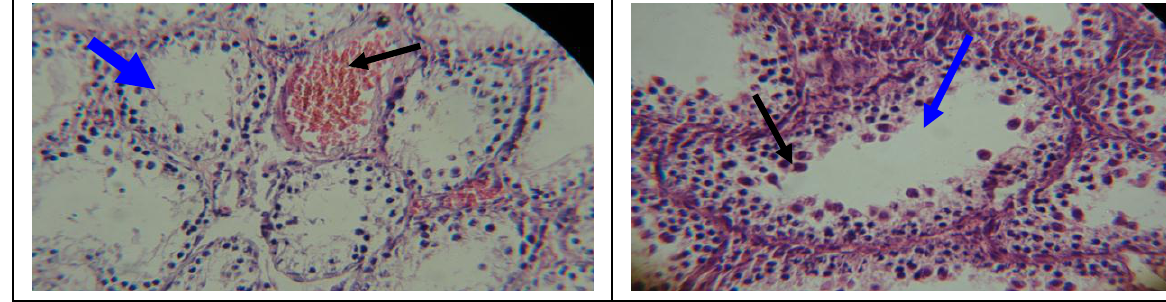
Figure(2): Histopathological section of testis of mice in therapeutic group treated with (estrogen and progesterone )showed incomplete spermatogenesis( ) with presence of multinucleated giant cell in the seminiferous tubules( ) after one month (H&E)40x.